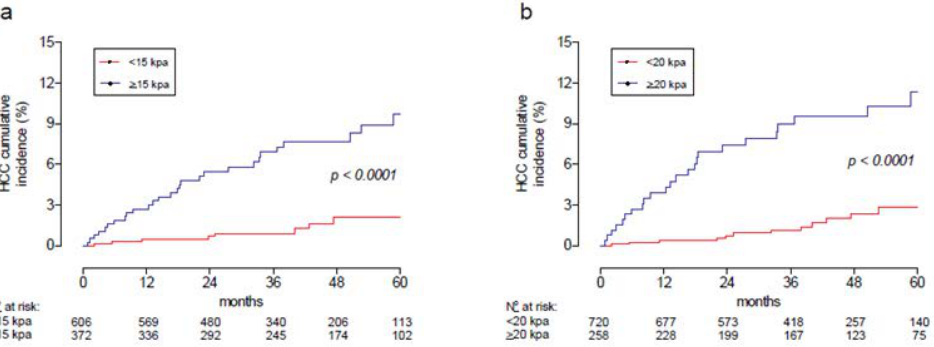
Figure 5. Incidence cumulative of HCC after the start of DAA treatment according to LSM <15 or ≥ 15 kPa ( a ) and <20 or ≥ 20 kPa ( b ) HCC: hepatocellular carcinoma; DAA: direct-acting antiviral